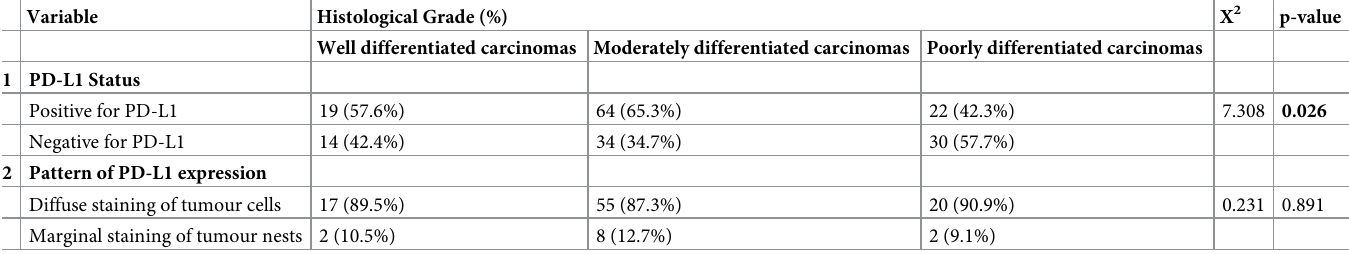
Table 1. Relationship between PD-L1 expression and histological grades of cervical carcinomas. Variable Histological Grade (%) X 2 p-value Well differentiated carcinomas Moderately differentiated carcinomas Poorly differentiated